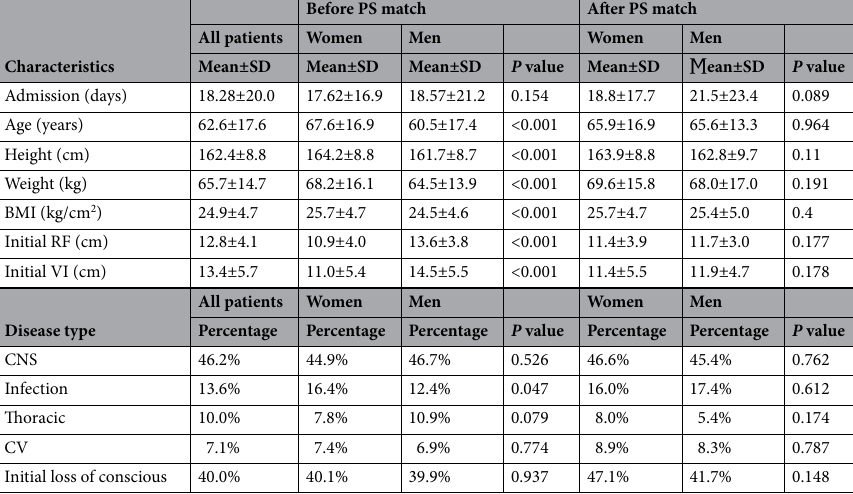
Before PS match After PS